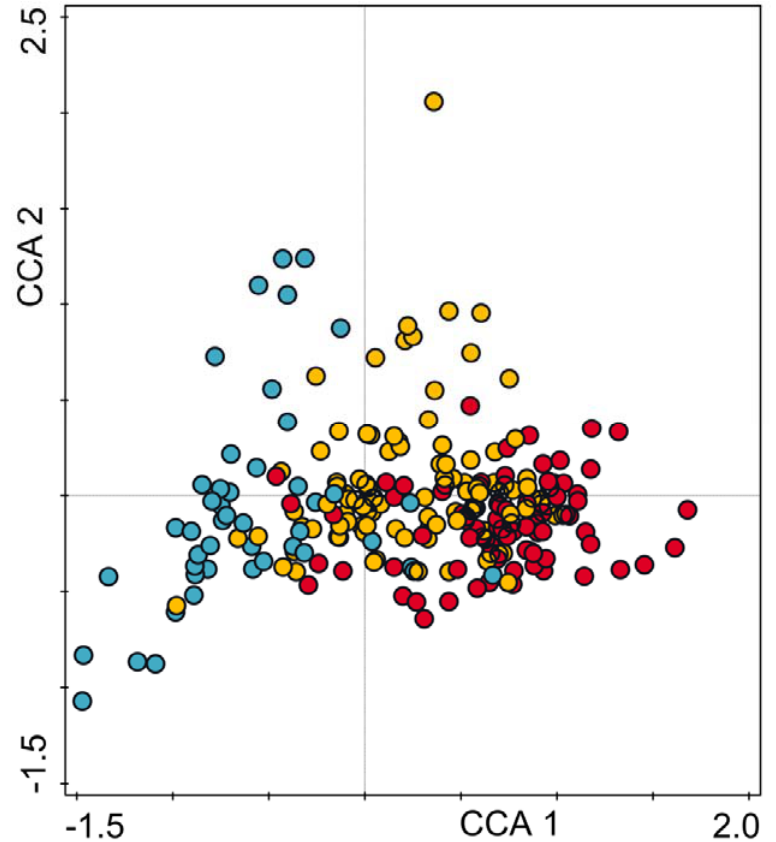
Figure 3. Ordination of study plots. Plots belonging to the dense built-up zone are marked in red, intermediate zone with scattered built-up fabric in orange and suburban forests in blue. Classification of plots is based on the analysis of the structural landscape elements. Compare Figure 1. Table 3. Simple term and conditional term effects of the studied variables. For abbreviations of urban environmental variables see Table 1. Tree species name abbreviations: Ace.plat— Acer platanoides , Ace.pseu— Acer pseudoplatanus , Bet.pend— Betula pendula , Car.betu— Carpinus betulus